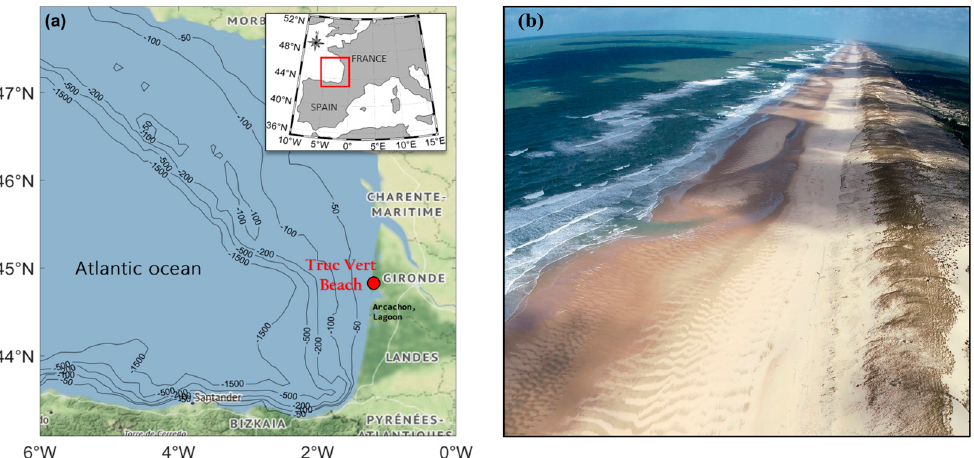
Figure 1. ( a ) Location map of Truc Vert beach in southwest France. ( b ) UAV photograph of Truc Vert (Ph. V. Marieu).